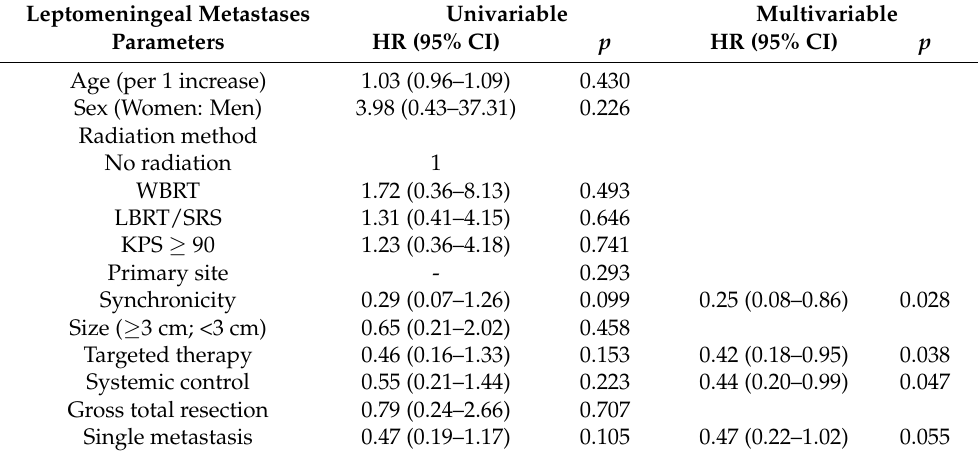
Table 5. Univariable and multivariable Cox regression for leptomeningeal metastases. Leptomeningeal Metastases Univariable Multivariable Parameters HR (95% CI)